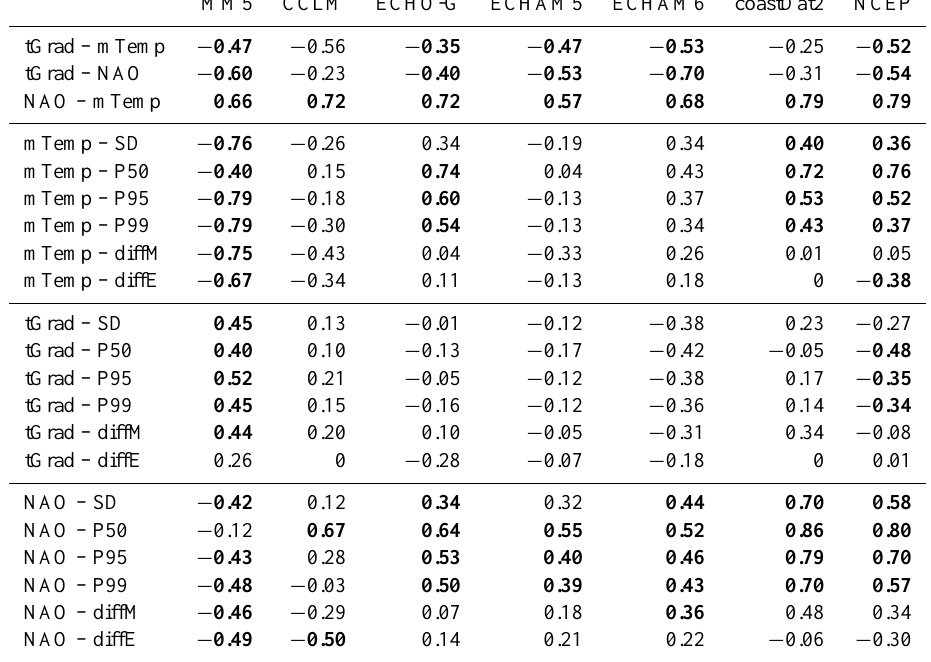
Table 3. Time correlation coefficients between the following parameters of the probability distribution of daily mean wind speed: standard deviation of wind speed (SD), the 50th, 95th and 99th percentile (P50, P95, P99) and the differences between P95-P50 (diffM) and P99-P95 (diffE) and some large-scale drivers: spatially averaged December-February air temperature (mTemp), the spatial air temperature gradient (tGrad) and the North Atlantic Oscillation index (NAO). The parameters of the probability distributions have been computed in 30-year sliding windows for the simulations and in 5-year sliding windows for the reanalysis products. The time series of the drivers have been smoothed with a running mean filter. Significant ( p < 0 . 05) coefficients (tested with a random phased bootstrap method) are written in